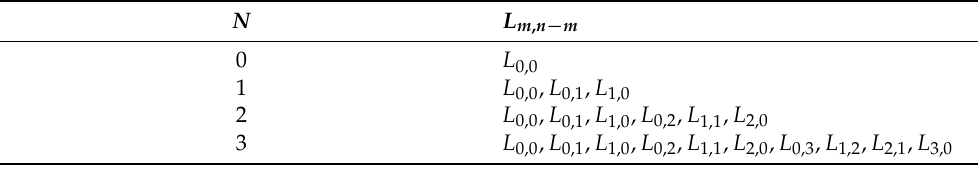
Table 2. Hermite coefficients ( L m , n − m ) related to the maximum decomposition order ( N ).